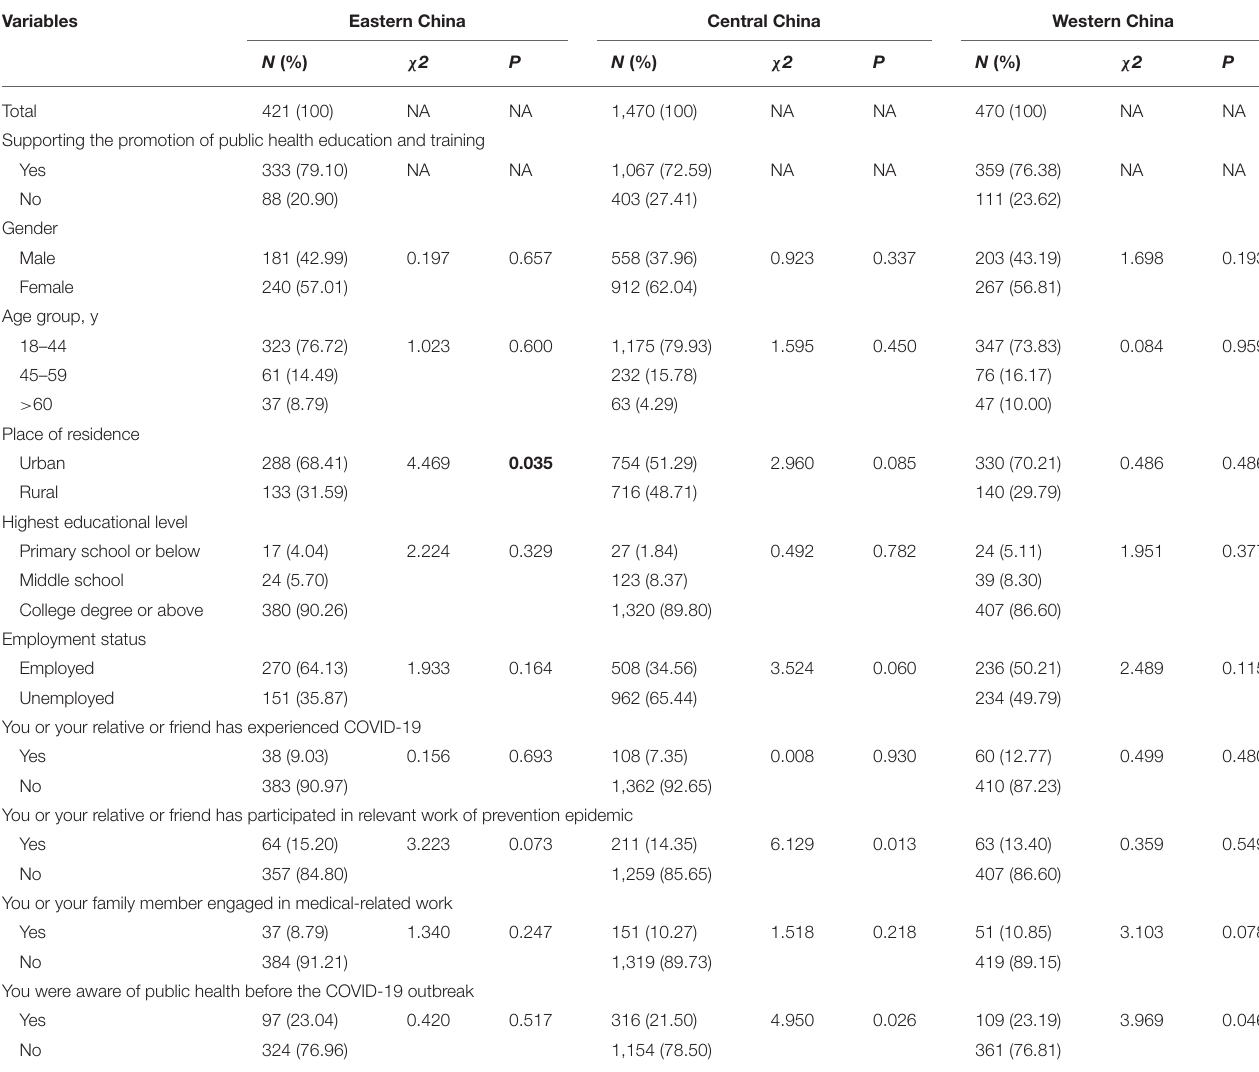
TABLE 2 | Univariate analysis of the differences in attitudes of developing public health professionals among the included residents stratified by geographic characteristics. Variables Eastern China Central China Western